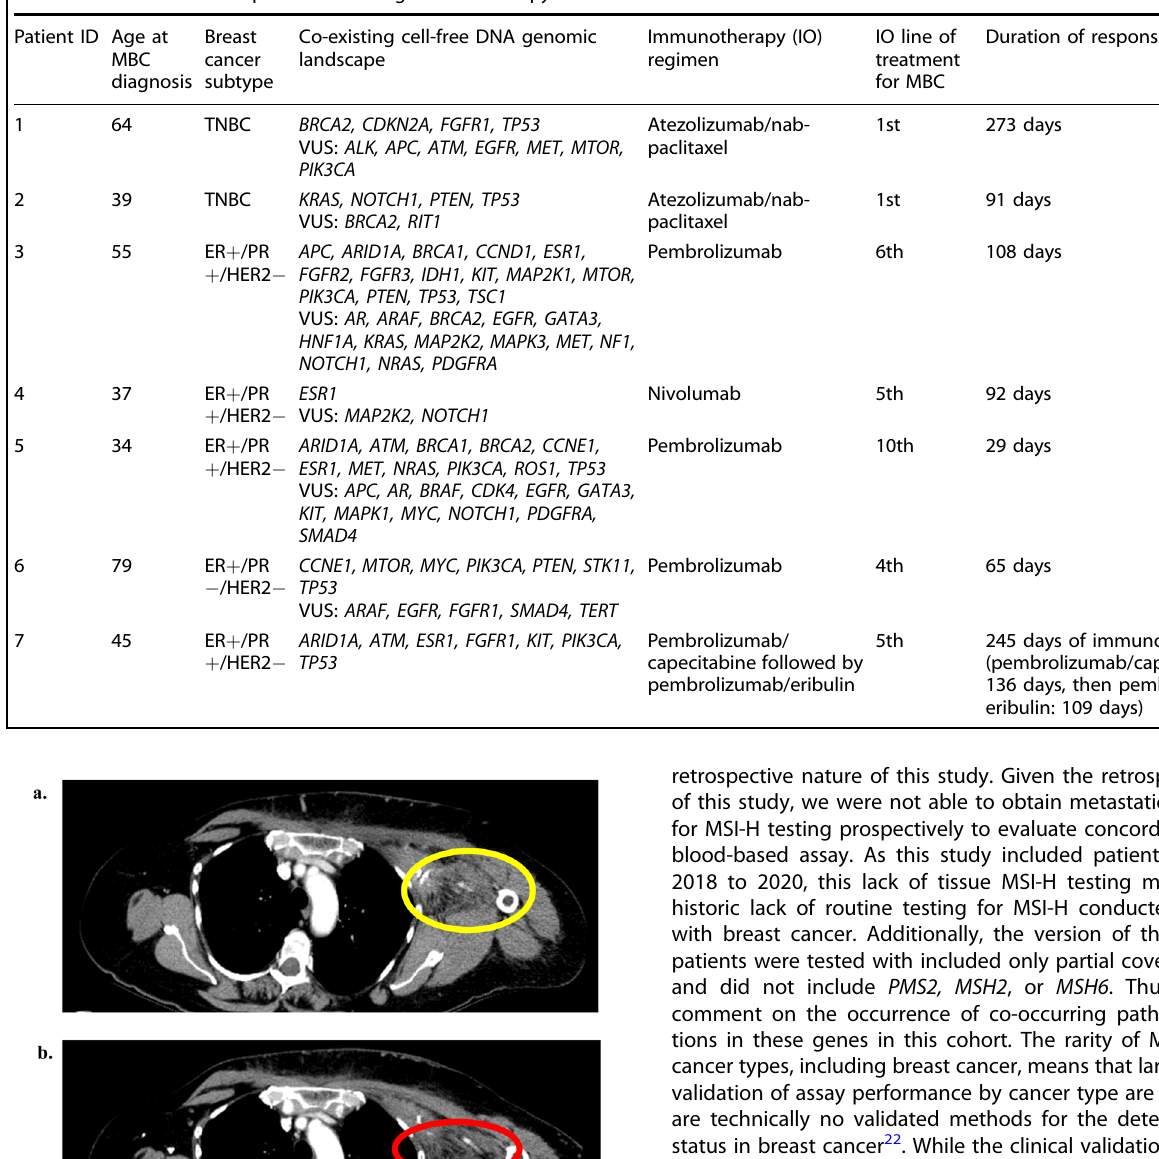
Table 2. Characteristics of patients receiving immunotherapy with MSI-H